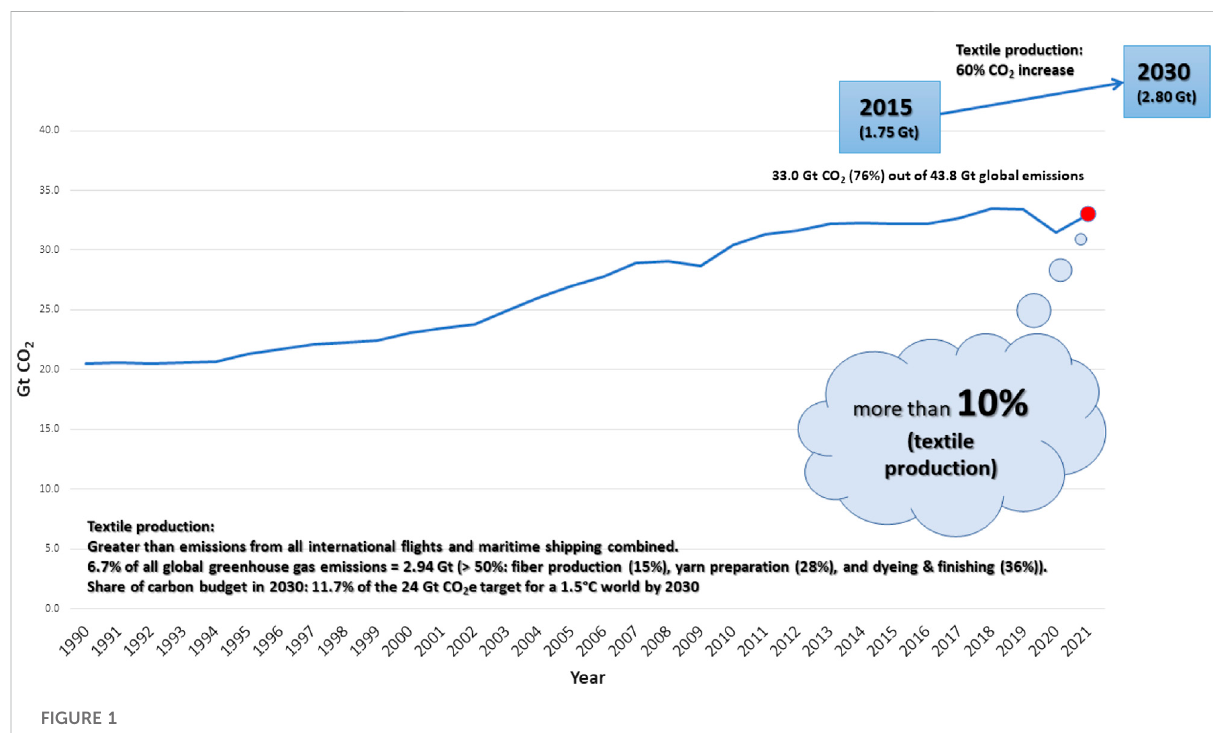
FIGURE 1 Textilecontributioncomparedtoglobalenergy(coal,oilandgas=76%ofglobalemissions)relatedemissions(1990 – 2021).Authors ’ own fi gure based on data adapted from (Kerr and Landry, 2017; Quantis, 2018; C2ES, 2021; IEA, 2021; European Parliament, 2021).